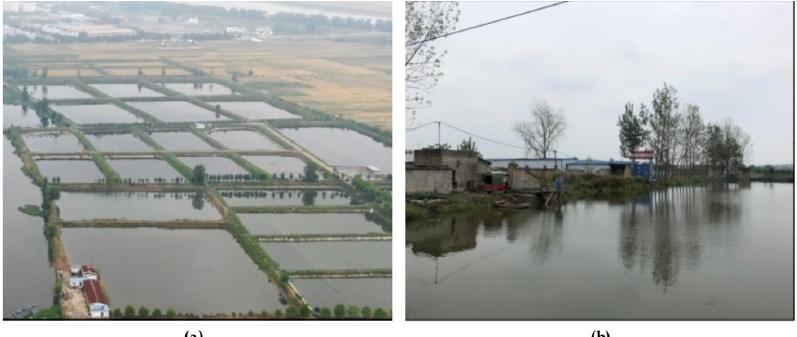
subsidence; ( b ) the subsidence area can be restored for raising geese. Source: Figures are from the